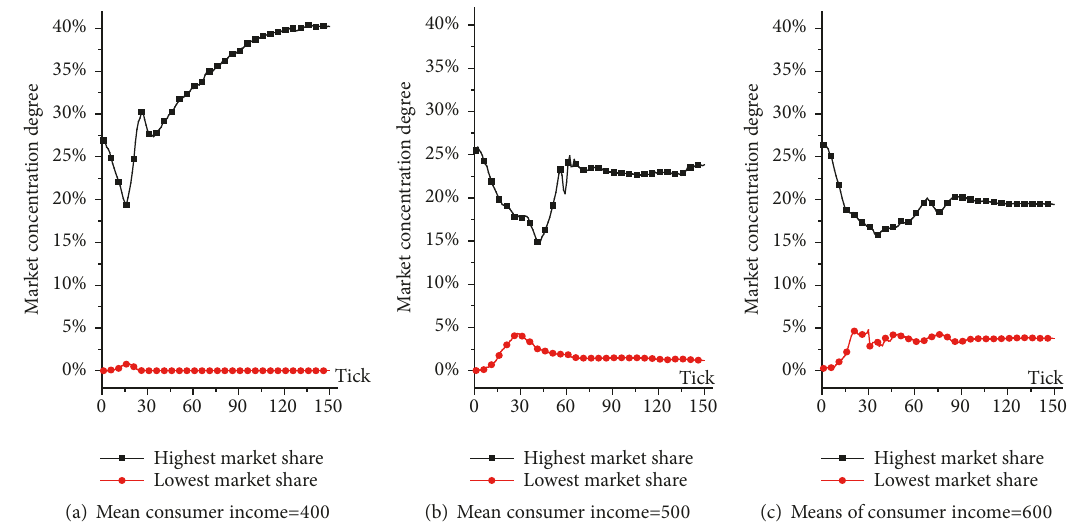
Figure 6: Highest and lowest market shares under different scenarios.